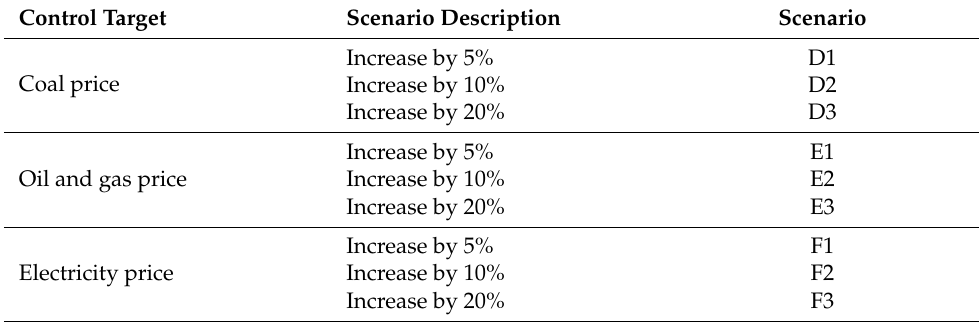
Table 4. Scenario description of energy price increase